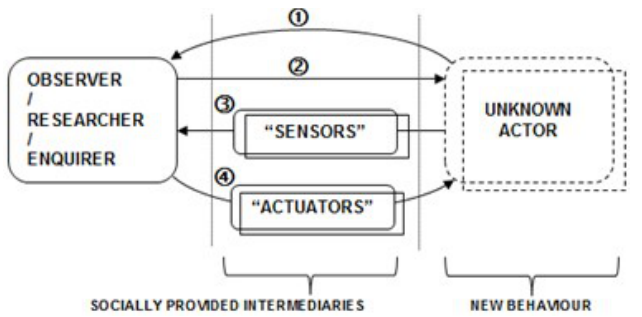
Fig. 19. Convergent epistemological conception between ANT and SAC: 1) direct observation; 2) direct action; 3) observation by other actor(s); 4) stimuli caused by other actor(s). The overlapping rectangles, with straight and rounded corners, mean either human or non-human can occupy the